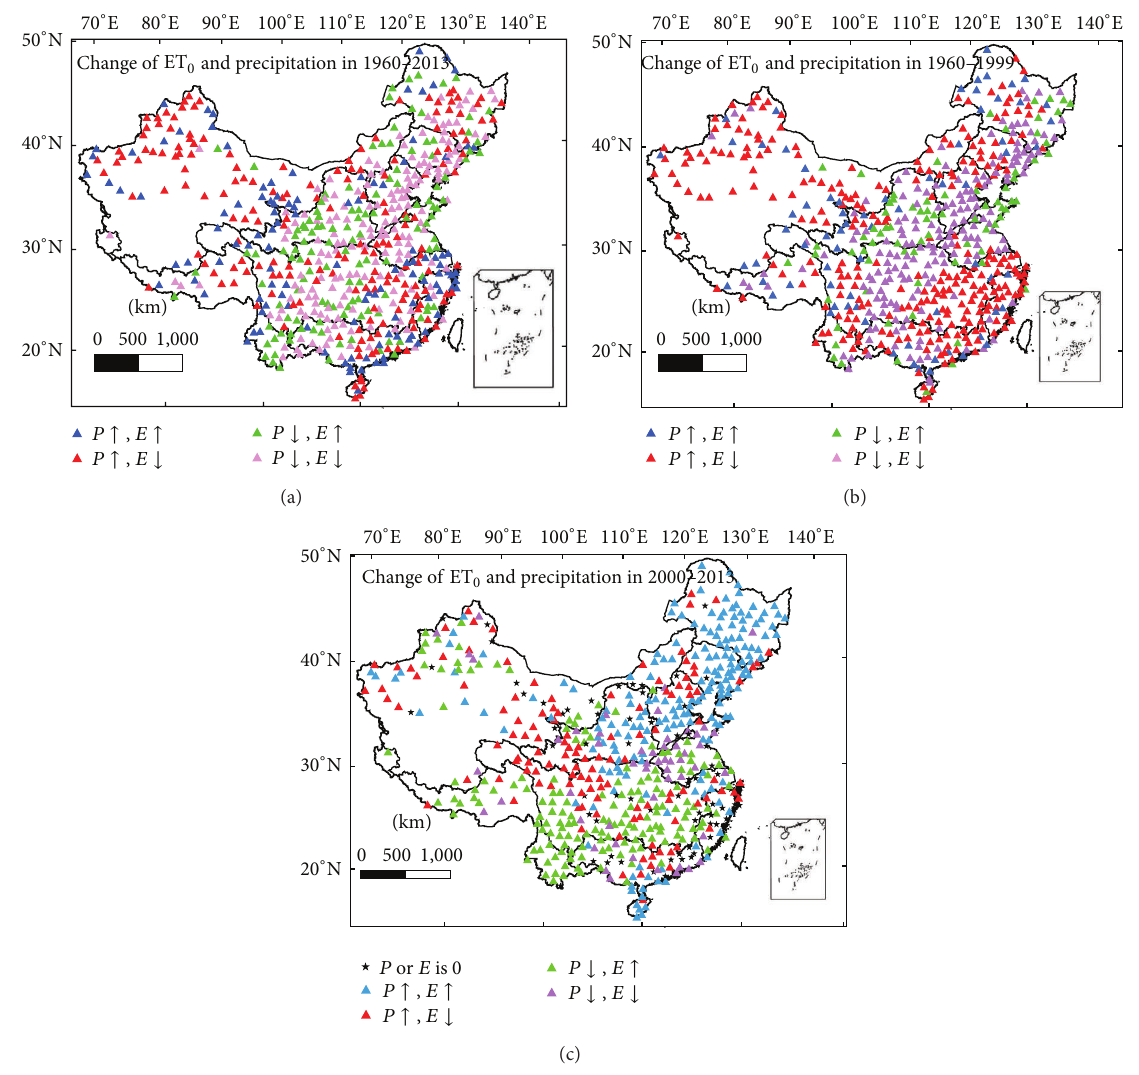
Figure 5: Change of precipitation and ET 0 in